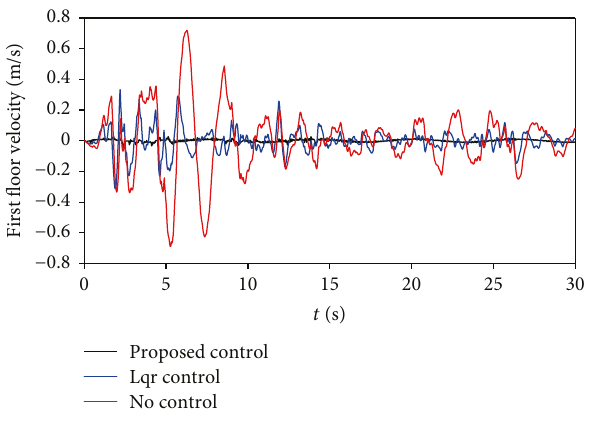
Figure 2: Velocity response example.